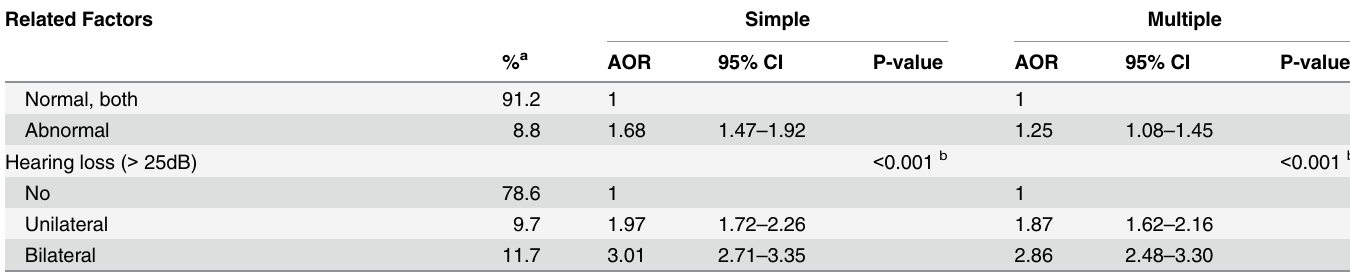
(Table 4). Because of the statistical insignificance, other factors were eliminated by backward elimination in this analysis.